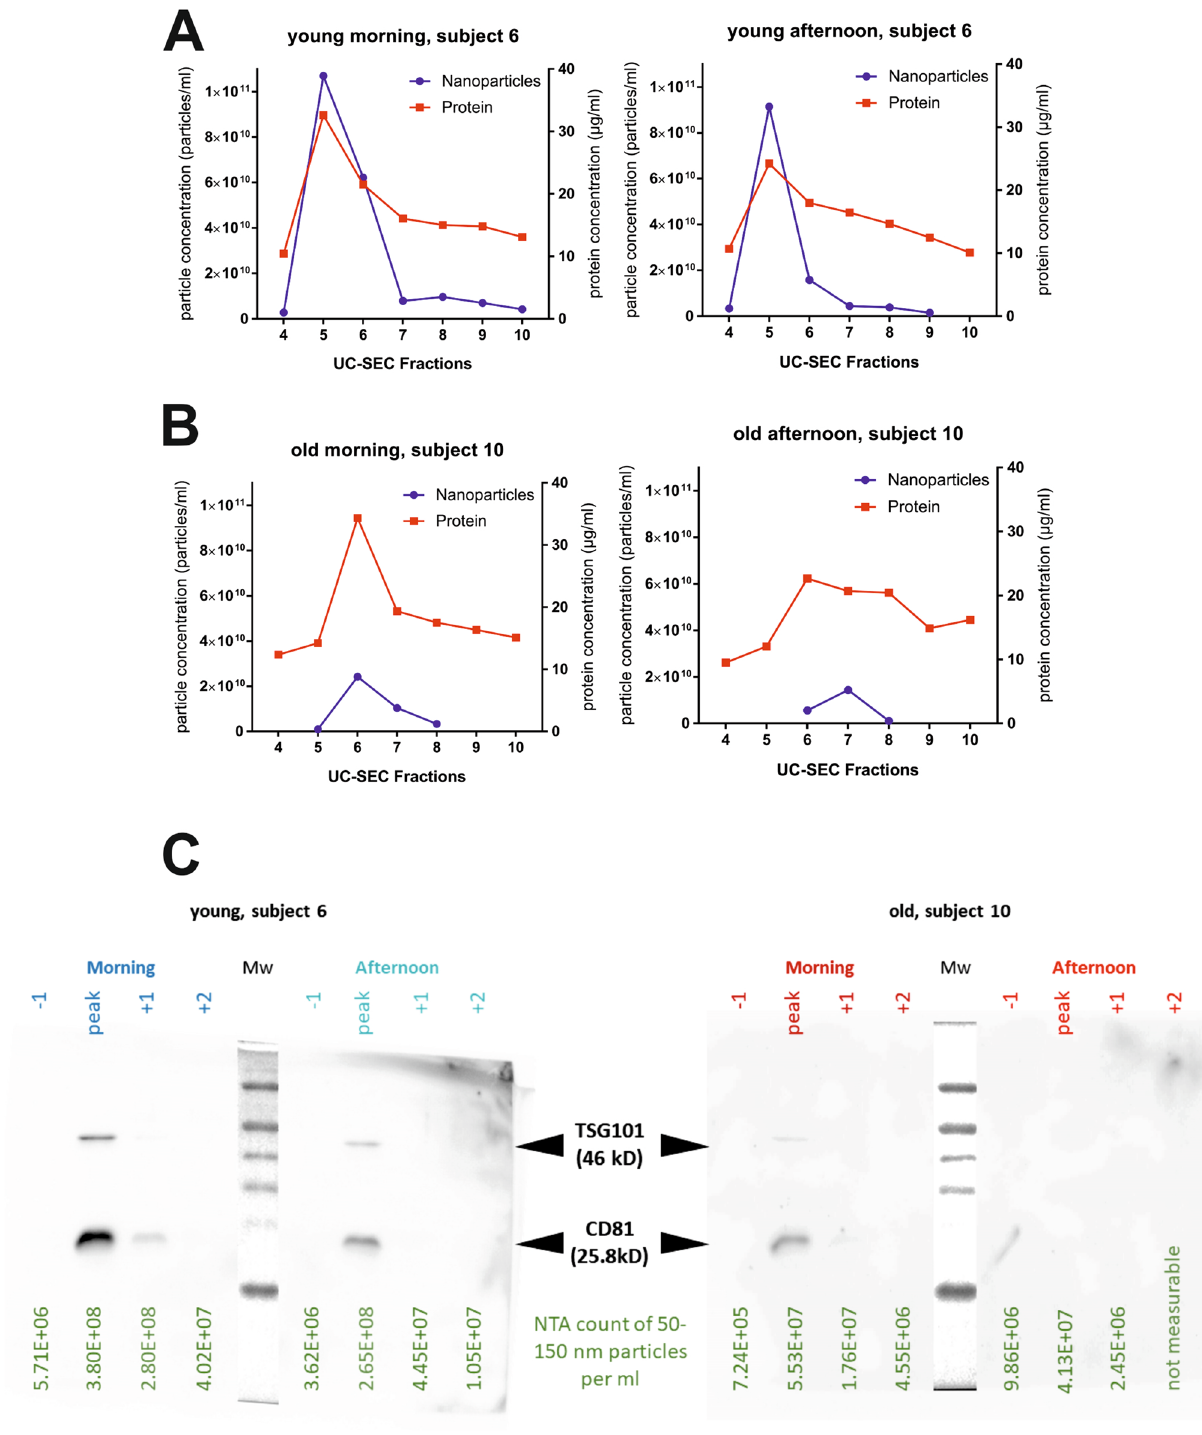
Figure 2. Exosomal markers and protein load in UC-SEC fractions from a young and an old representative sample. (A) Particle and protein concentrations in peak fractions of the UC-SEC of a young subject 6 (age 39 year old). The data for first-void urine uEVs isolation (left) and afternoon void urine insolation (right) are shown. (B) Particle and protein concentrations in peak fractions of the UC-SEC of an old subject 10 (age 59 year old). The data for first-void urine uEVs isolation (left) and afternoon void urine insolation (right) are shown. (C) Exosomal markers CD81 and TSG101 were tested by Western blotting in 27 µl of fractions including the peak of particle concentration determined by NTA from each isolation (subjects 6 and 10). NTA particle content for 50–150 nm exosomes of each lane indicated. Uncropped images of 2 blots (young subject 6 and old subject 10 with Mw markers) are